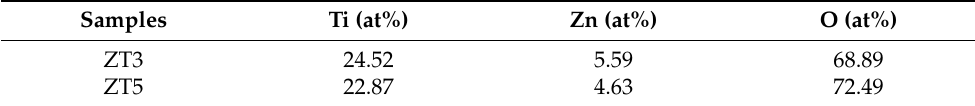
Table 1. The composition of ZT3 and ZT5.